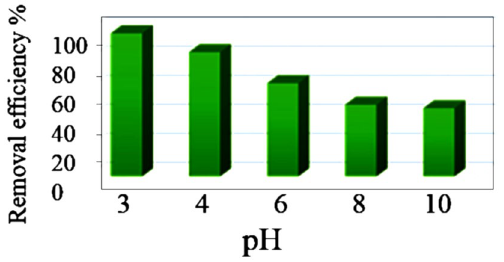
Figure 9. The effect of pH on the adsorption of AG-25 by Ch-rGO/Fe 3 O 4 . Experimental conditions: adsorbent contact time 180 min, dye concentration 0.1 mg mL −1 , RT, and adsorbent dose 0.010 g.